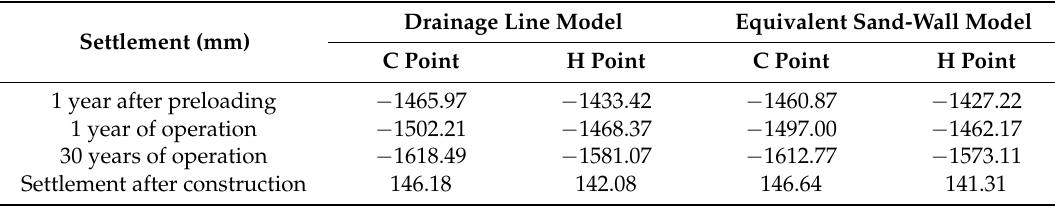
Table 7. Variation of settlements of the field test